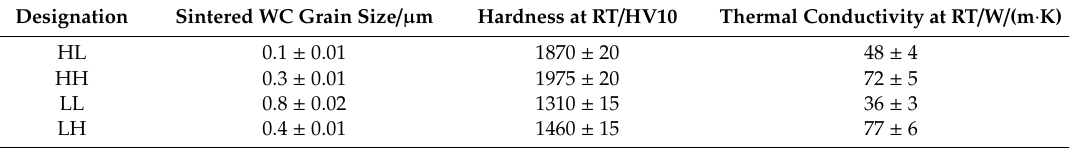
Table 2. Properties of sintered cemented carbides at room temperature (RT)